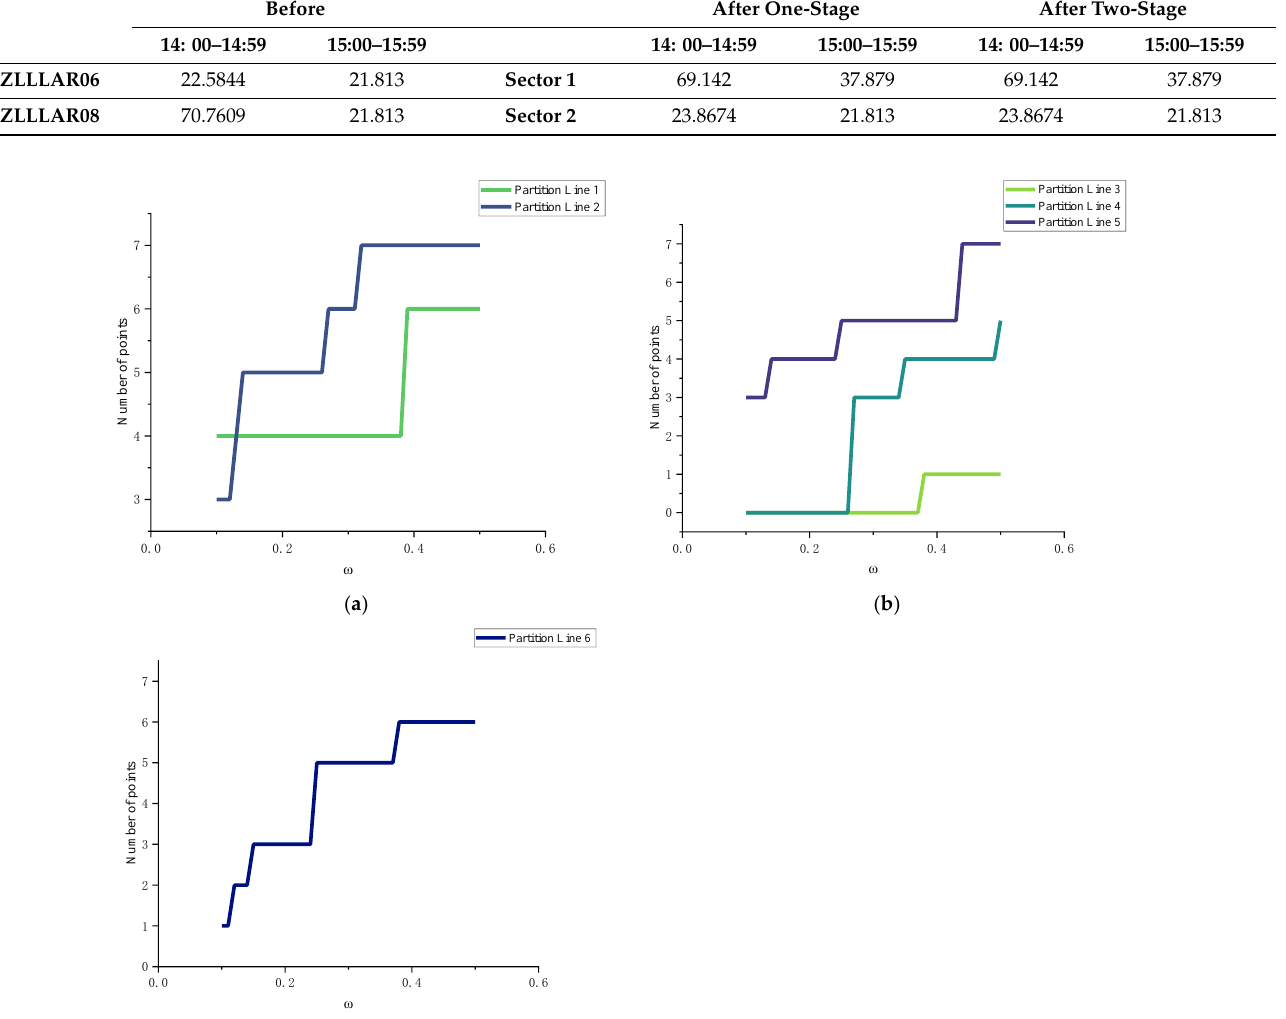
threshold. After experiments, at the weight value of 0.25, the sector workloads delin- eated by the optimized partition lines 2 and 6 exceed the threshold, so the one-stage divi- sion results are maintained; the rest of the lines meet all requirements. Figure 10. ( a ) The relationship between the number of points connected by partition line 1–2 and ω ; ( b ) The relationship between the number of points connected by partition line 3–5 and ω ; ( c ) The relationship between the number of points connected by partition line 6 and . ond stage. Tables 7 – 9 show the comparison of the workload of each sector before and after the division. For the three time periods, we choose the weight value of 0.25 to optimize all the partition lines, taking into account the utilization rate of the points within the airspace as well as the smoothness of the sector boundaries. At the same time, it is still necessary to consider whether the optimized segmentation lines and new sectors satisfy the constraints of sector boundary optimization and the requirement that all workloads do not exceed the